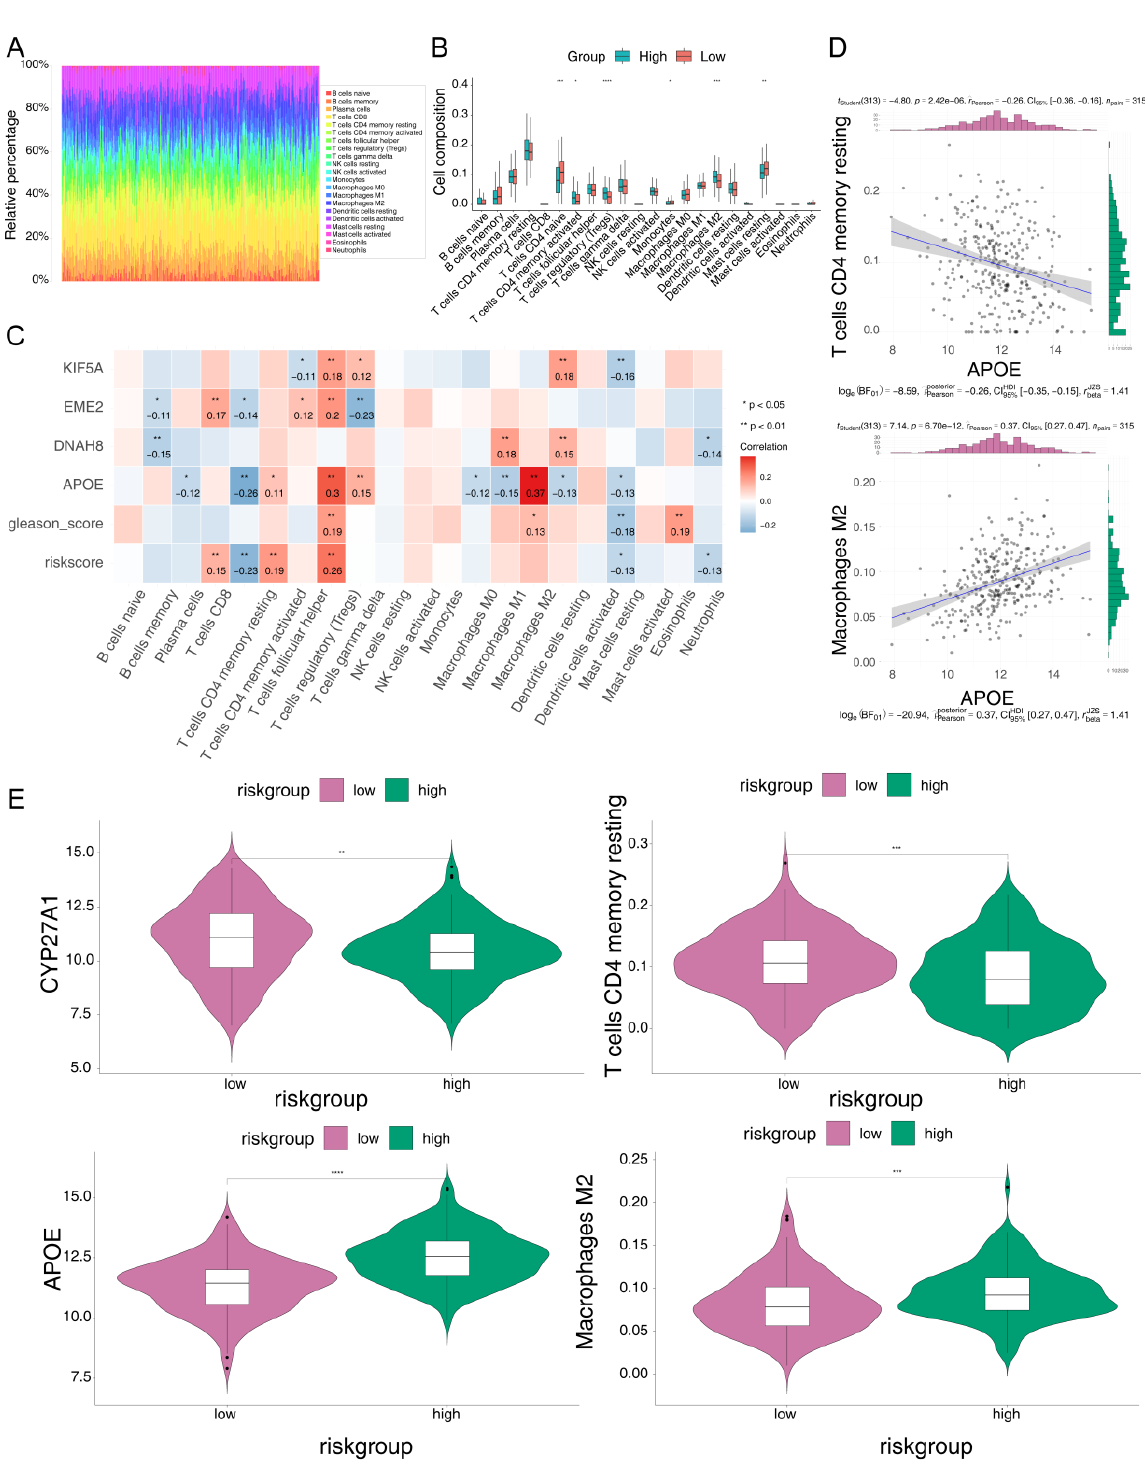
Figure 4. Correlation between risk scores and immune cell infiltration. ( A ) The relative percentage of the 22 immune cell types. ( B ) Box plot of the immune cell proportion. * p < 0.05; ** p < 0.01; *** p < 0.001; **** p < 0.0001; ns-not significant. ( C ) Correlation analysis of model genes and immune cells. ( D ) Correlation scatter plots of model genes and immune cells. ( E ) Differences in model genes and immune cells between the high- and low-risk groups.